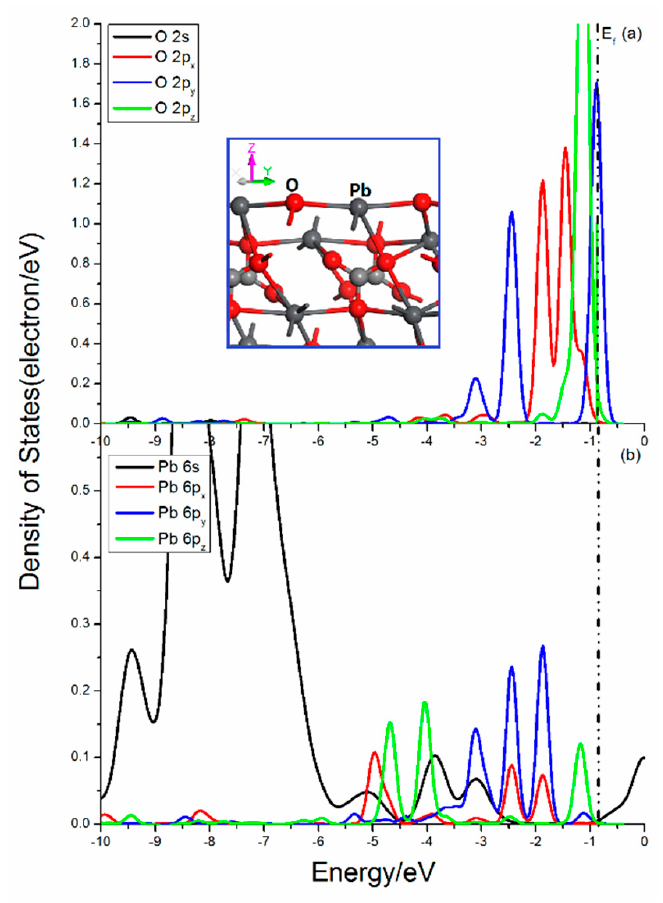
Figure 5. Projected DOSs of O and Pb of cerussite (110) surface: ( a ) O 2s, 2p x , 2p y and 2p z states; ( b ) Pb 6s, 6p x , 6p y and 6p z states.